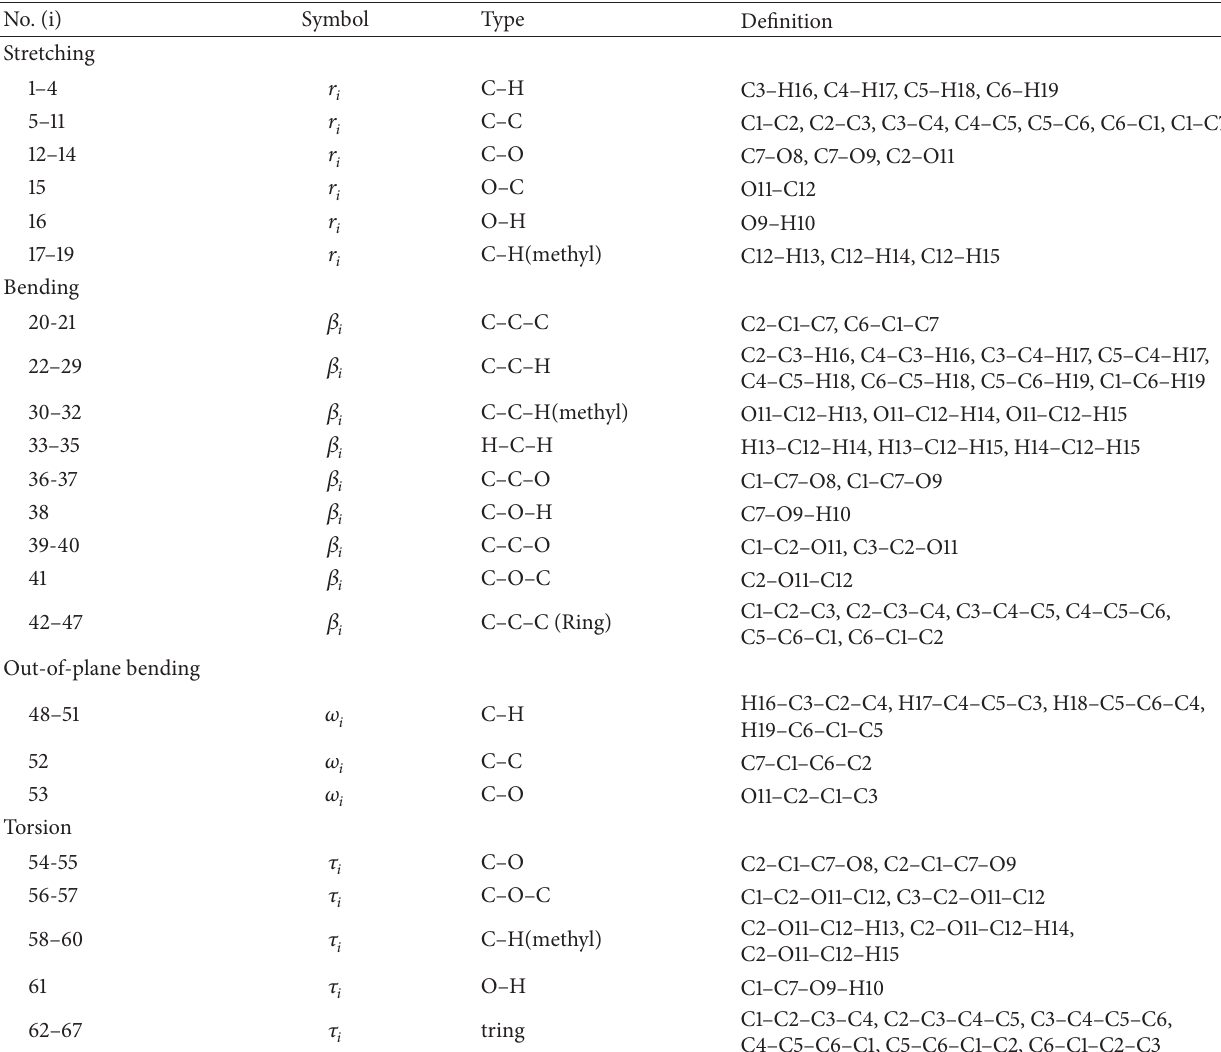
Table 2: Definition of internal coordinates of O-Anisic acid